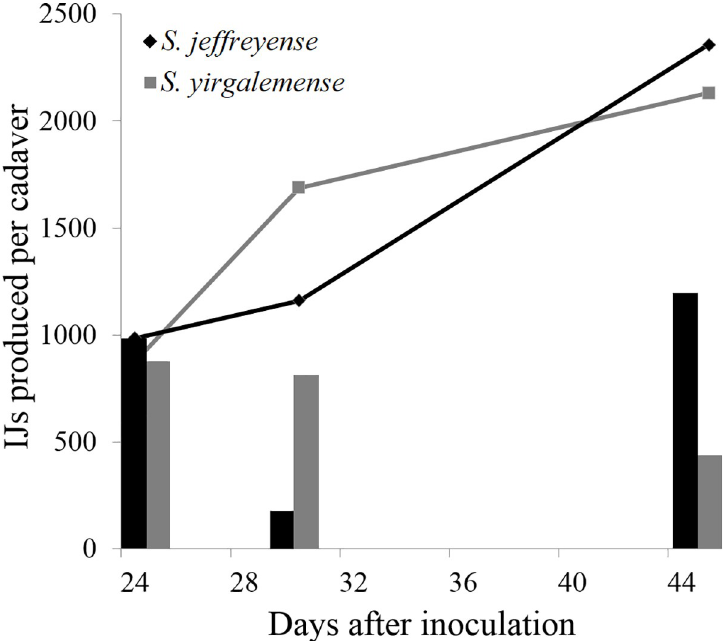
Fig 6. Average number of infective juveniles (IJs) produced per cadaver of Lobesia vanillana larvae. Cadavers from susceptibility bioassays were rinsed and incubated on modified White Traps, and the number of next generation infective juveniles produced was recorded for each treatment, from three harvests over the course of 45 days. Lines indicate cumulative